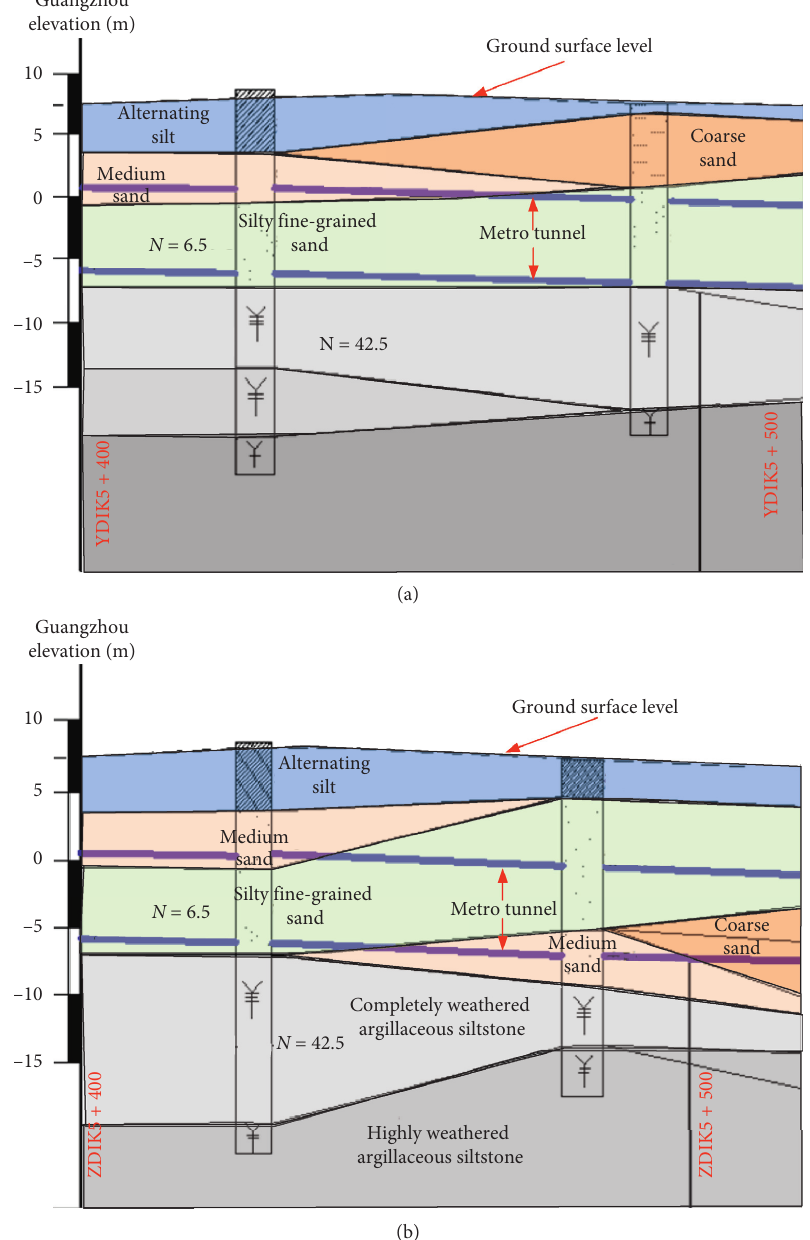
Figure 6: Geological profiles of the tunnels. (a) Geological profile of the eastbound tunnel. (b) Geological profile of the westbound